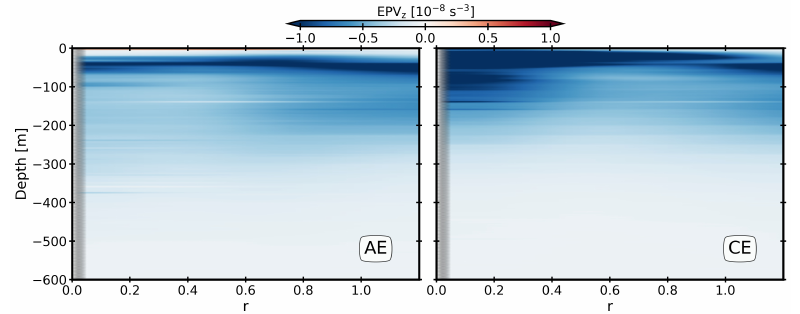
Figure 19. The vertical component of the EPV for the CE and AE.